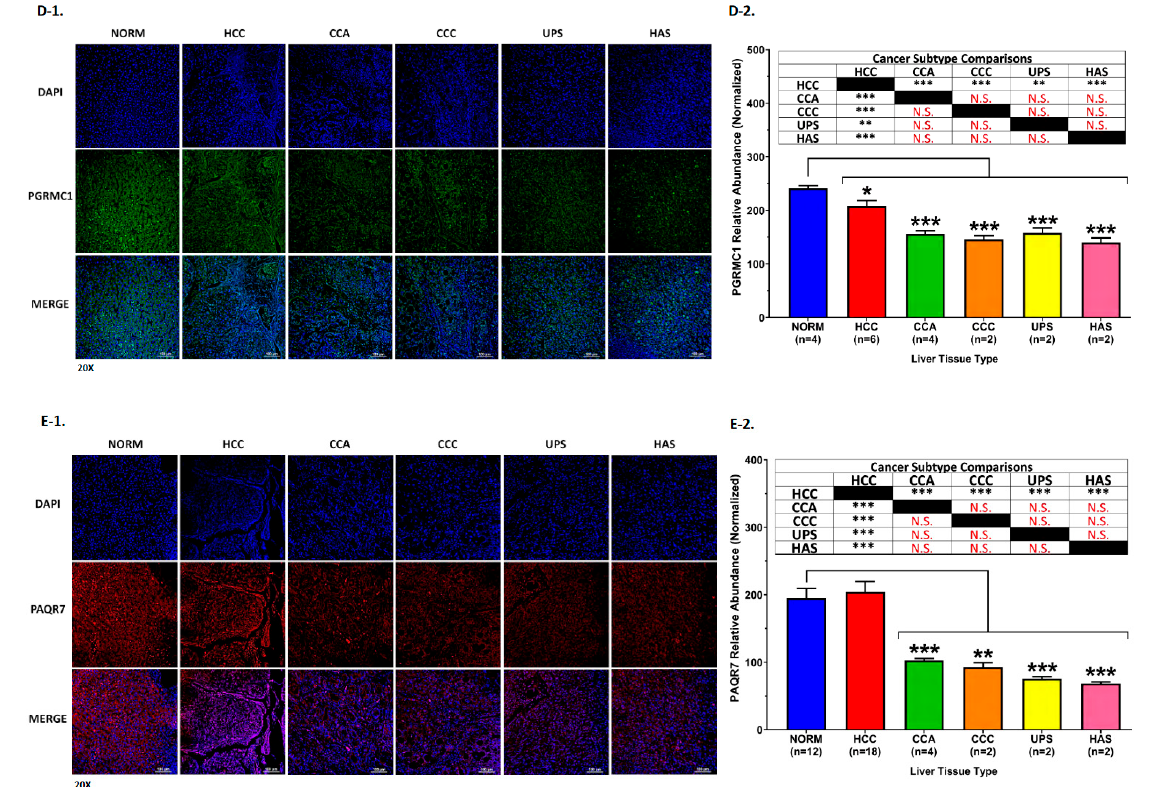
Figure 4. Significantly altered CmPn protein expression among hepatic cancer subtypes. Compara- tive CmPn protein expression patterns were measured with immunofluorescence-labeled antibod- ies, normalized against nuclear staining (DAPI), and quantified using Nikon Elements Analysis software. ( A-1 ) Representative IF images of CCM1 protein expression among different liver cancer types and NORM tissues. ( A-2 ) Normalized quantification for all images. ( B-1 ) Representative IF images of CCM3 protein expression among different liver cancer types and NORM tissues. ( B-2 ) Normalized quantification for all images. ( C-1 ) Representative IF images of PAQR8 protein expres- sion among different liver cancer types and NORM tissues. ( C-2 ) Normalized quantification for all images. ( D-1 ) Representative IF images of PGRMC1 protein expression among different liver cancer types and NORM tissues. ( D-2 ) Normalized quantification for all images. (E-1 ) Representative IF images of PAQR7 protein expression among different liver cancer types and NORM tissues. ( E-2 ) Normalized quantification for all images. For all graphs, asterisks above each cancer type indicate significance of differential expression between specific cancer type and NORM tissues. Cancer sub- type comparisons chart above each graph summarizes the relationships within cancer subtypes. Sample sizes provided beneath liver tissue type. In all bar plots and charts, ***, **, and * indicates p ≤ 0.001, ≤ 0.01, and ≤ 0.05, respectively, N.S. means non-significant, using one-way ANOVA.